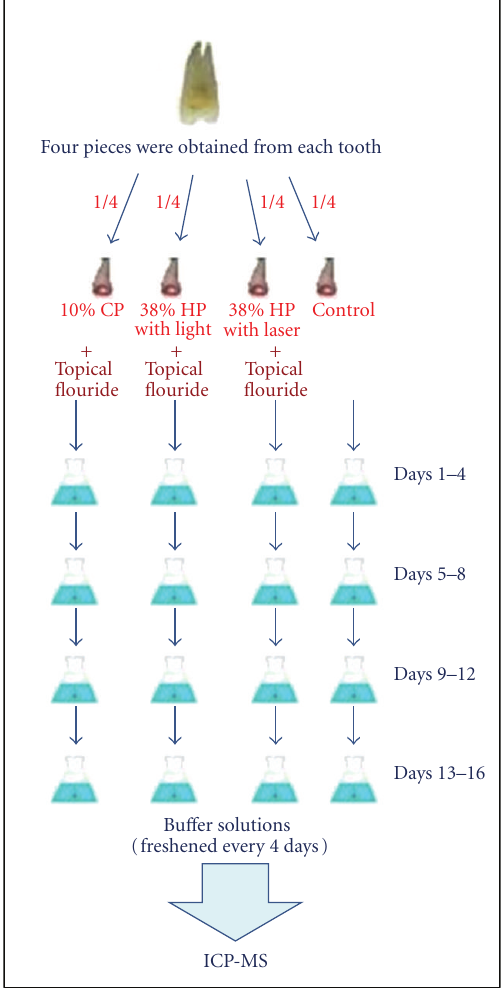
Figure 2: The specimens were treated with the bu ff er four times every four days, in 16 days. The solutions in the tubes were tested for their Ca 2+ loss with Inductively Coupled Plasma-Mass Spectrome- try (ICP-MS).